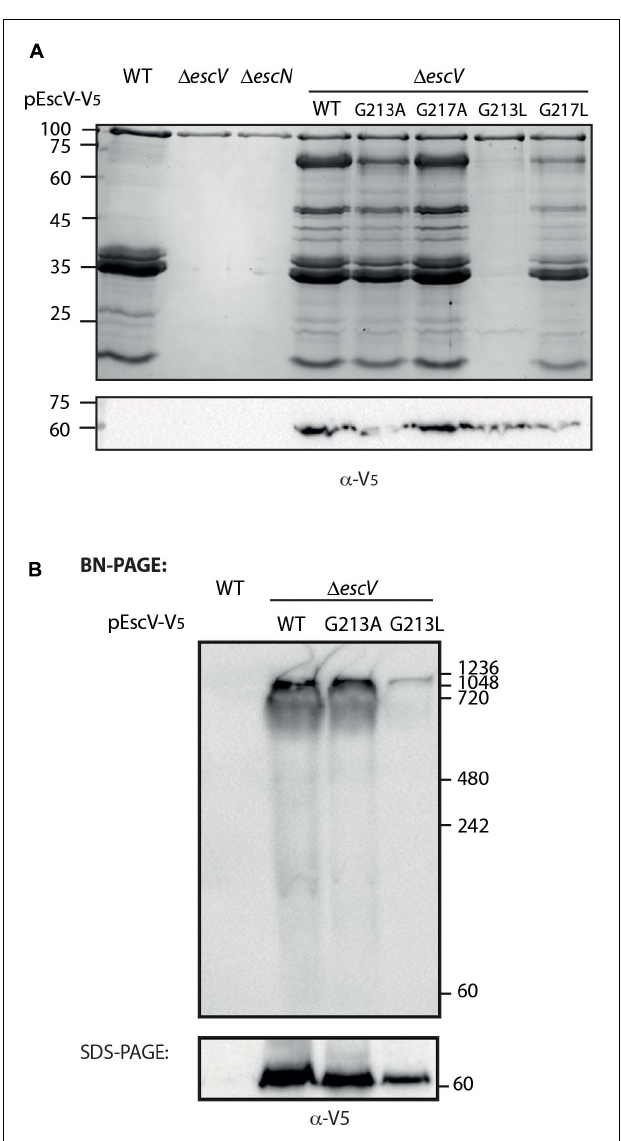
FIGURE 7 | The glycine residue at position 213 is critical for the T3SS activity. (A) Protein secretion profiles of EPEC strains grown under T3SS-inducing conditions: WT, (cid:49) escN , (cid:49) escV , and (cid:49) escV complemented with EscV wt -V5, EscV G213A -V5, EscV G217A -V5, EscV G213L -V5, or EscV G217L -V5. The secreted fractions were concentrated from the supernatants of bacterial cultures and analyzed by SDS-PAGE and Coomassie blue staining. The expression of EscV-V5 variants were examined by analyzing the bacterial pellets by SDS-PAGE and western blot analysis with an anti-V5 antibody. (B) Membrane protein extracts of WT EPEC and (cid:49) escV expressing EscV wt -V5, EscV G213A -V5, or pEscV G213L -V5 were incubated in BN sample buffer and then subjected to BN-PAGE (upper panel) or SDS-PAGE (lower panel) and western blot analysis using anti-V5 antibody. Molecular masses in kilodaltons are presented on the right.